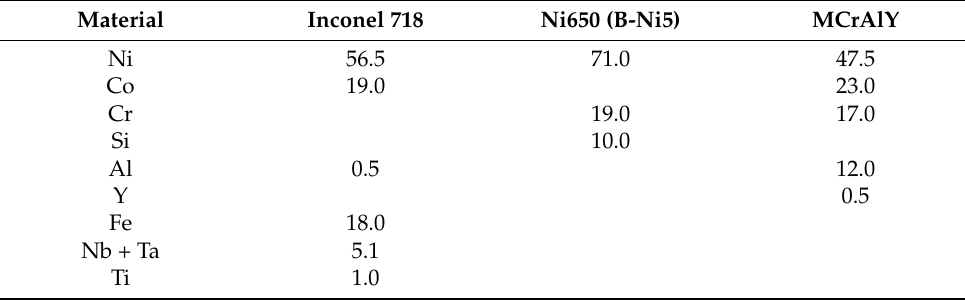
Table 1. Chemical composition (in mass%) of the materials employed.